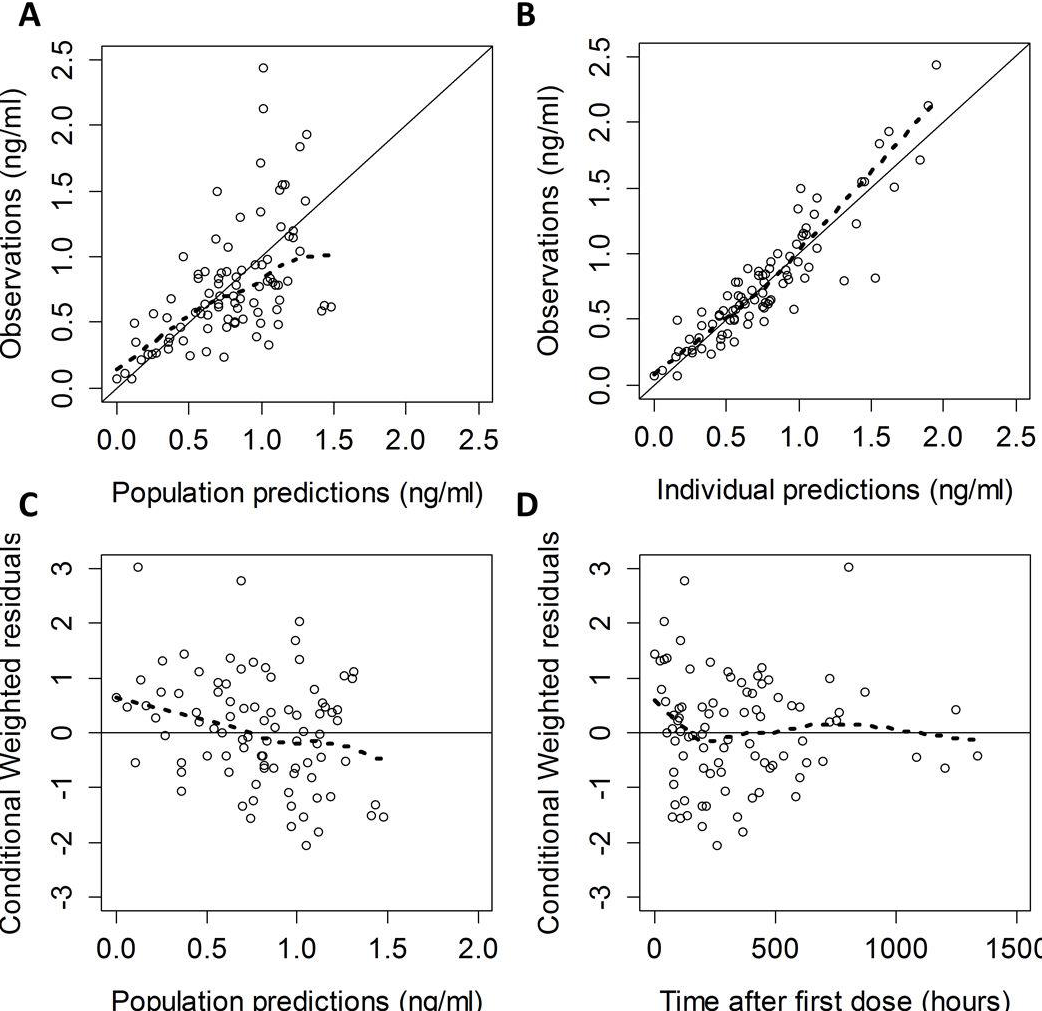
Figure 1. Final population pharmacokinetic (PK) model diagnostic plots: observed versus population prediction ( A ) and individual prediction ( B ), conditional weighted residuals versus population predictions ( C ), and time after last dose ( D ). The solid line in A and B is the line of identity. The solid line in C and D is a reference line at y = 0. The dashed lines in A, B, C, and D are smooth lines. A small pilot study in term neonates examined scaled pharmacokinetic models that were obtained by applying allometry and maturation to already published data. The clearance of